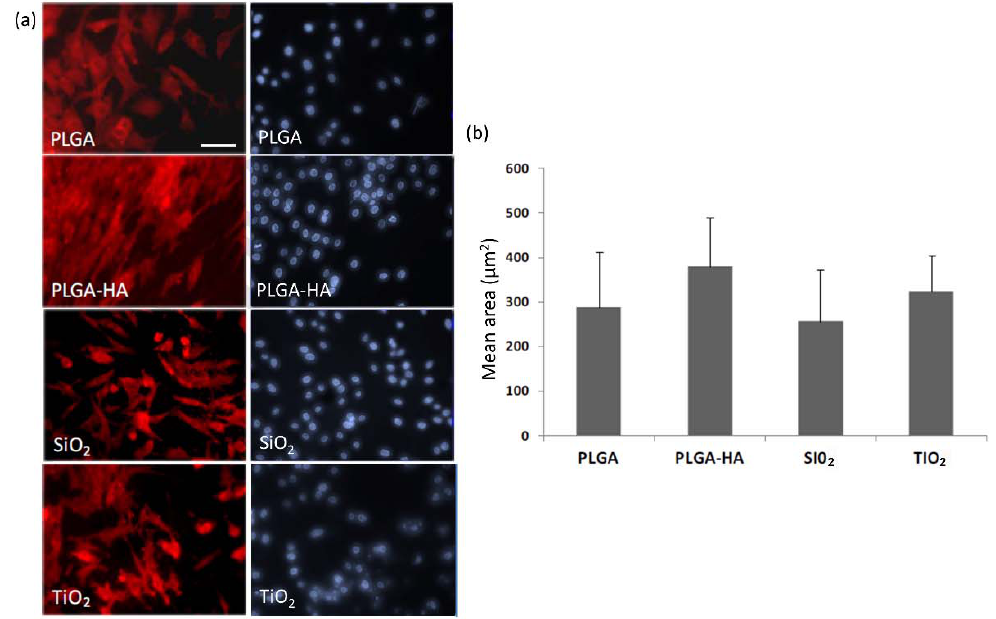
Figure 4. ( a ) Microphotography of the osteoblasts on studied membranes stained with phalloidin-TRITC 50 (red) and DAPI (blue). ( b ) The mean + SD of the areas of the cells adhered to the membranes is shown. Bar in PLGA = 10 microns (same scale for all images).